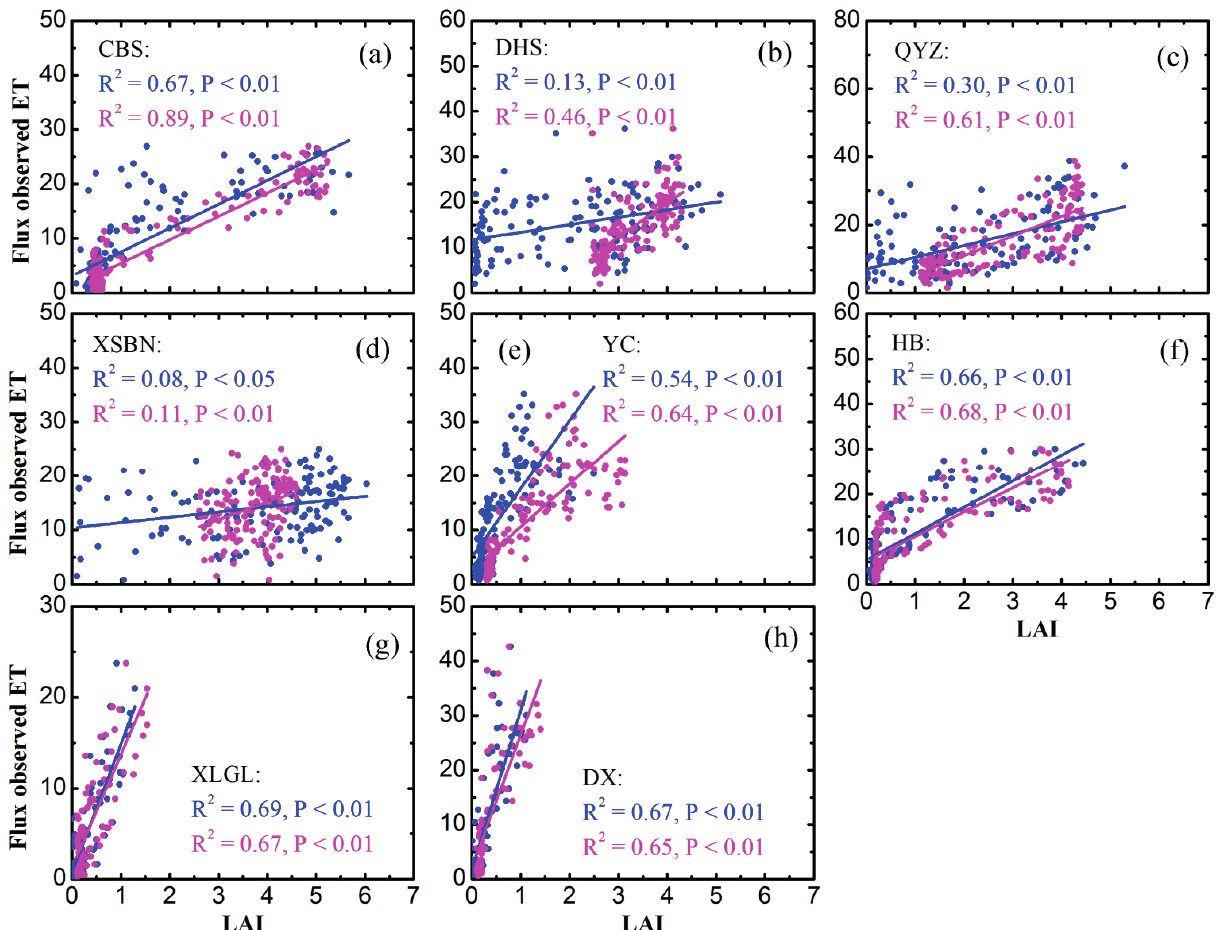
Figure 5. Relationship between flux observed ET (with mm/8-day) and GLASS-LAI (pink)/MODIS-LAI (blue) for each site. ( a ) in mixed forests site; ( b ) in evergreen broadleaf forests site; ( c ) in evergreen needleleaf forests site; ( d ) in evergreen broadleaf forests site; ( e ) in croplands; ( f , g , h ) in grasslands